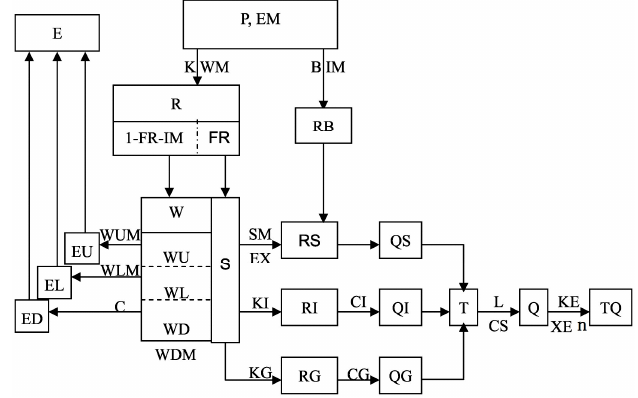
Figure 1. Structure diagram of the three runoff components of the Xinanjiang model. Table 1. Parameters of the Xinanjiang model.